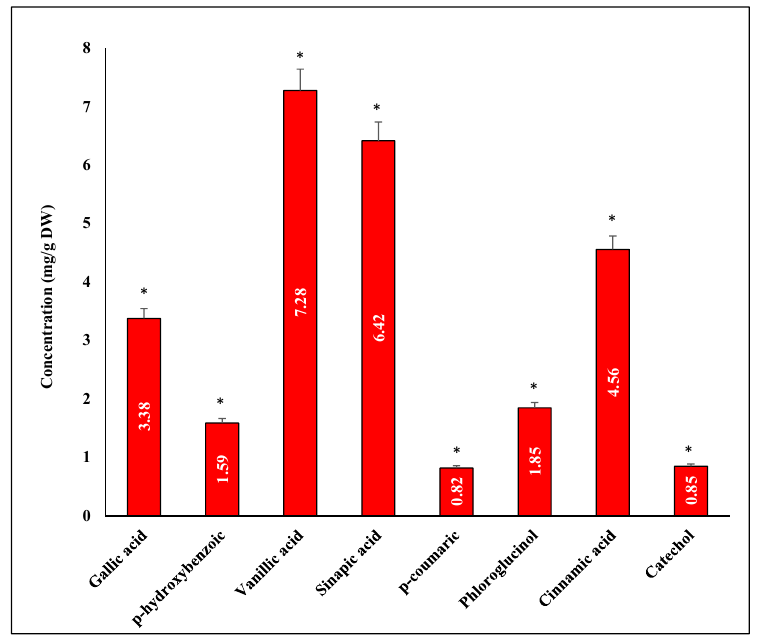
Figure 9. HPLC profile of phenolic compounds in methanol extract of G. compressa (highly significant = * p < 0.05, n = 3).